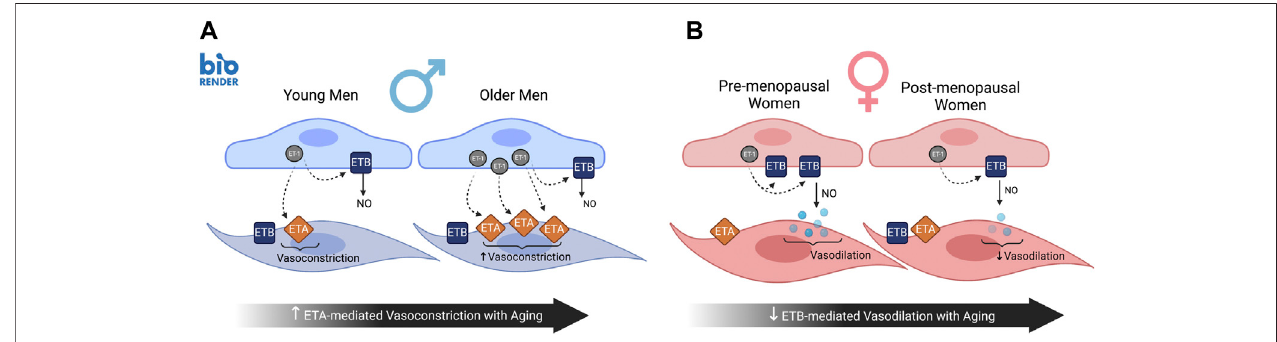
FIGURE 4 | Sex differences in ET-1 signaling pathway with aging impacting endothelial function. In men, aging is associated with overexpression of cellular ET-1 and greater ETA receptor mediated vasoconstriction (A) , both of which contribute to declines in endothelial function. In contrast, the age-related decline in endothelial function in women is mediated in part by decreased endothelial ETB receptor expression and loss of ETB-mediated vasodilation (B) . Created with BioRender.com.